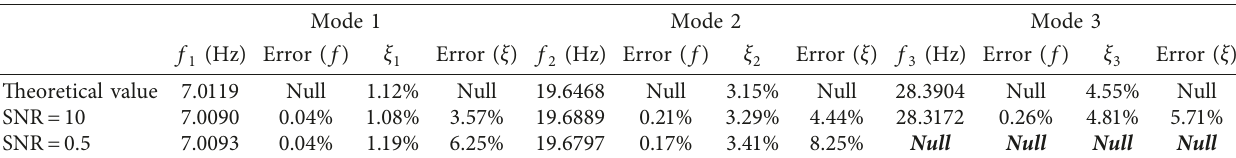
Table 3: ACS-SSI